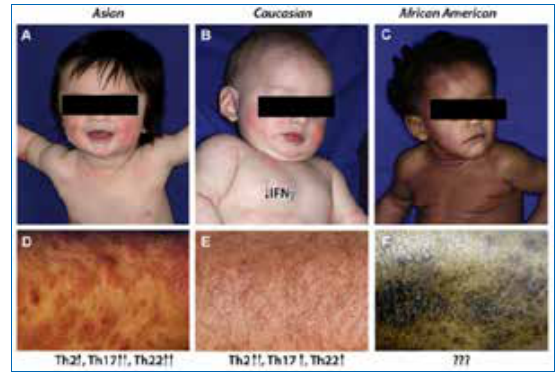
Figure 3. Different races and AD